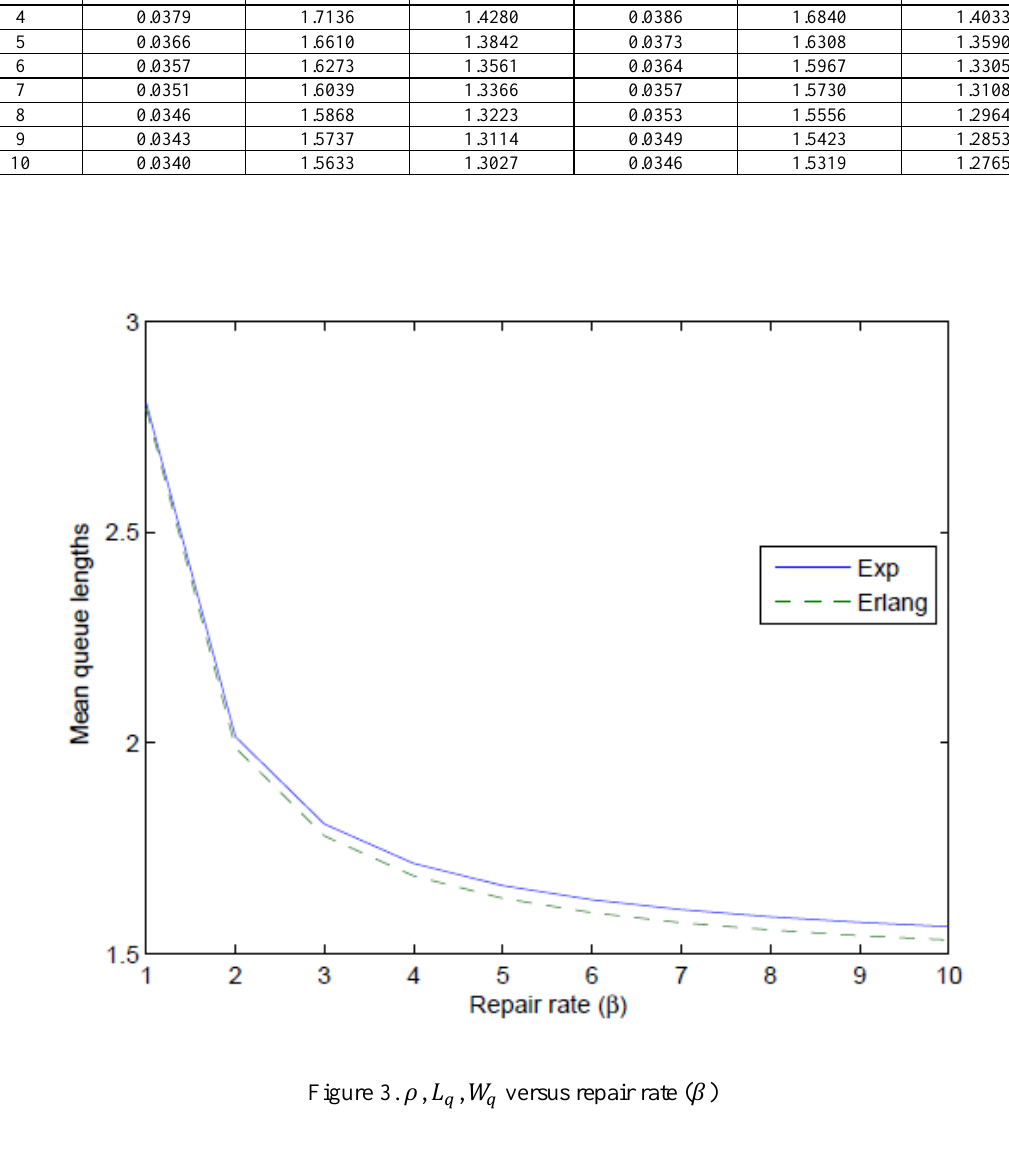
, 𝑊 versus repair rate ( 𝛽 𝑞 𝑞